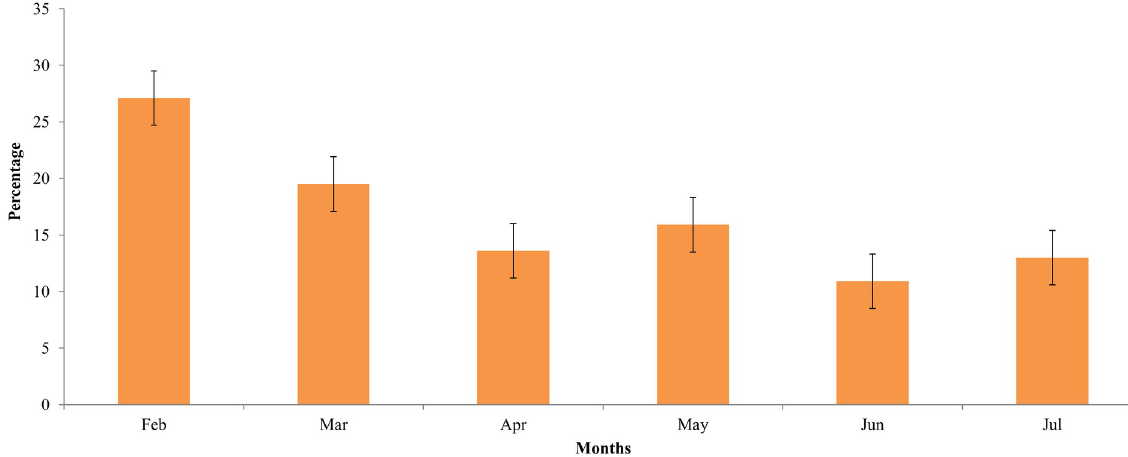
Fig 2. The overall monthly distribution of tsetse flies in the study area.